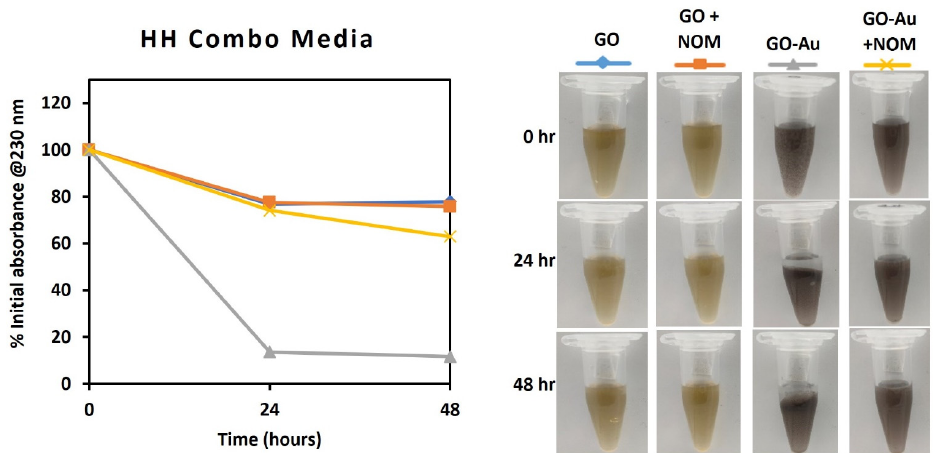
Figure 6. Monitoring of dispersion stability of GO and GO-Au in HH Combo media with and without NOM (20 mg/L). (left): Absorbance measured in UV ‐ vis; (right): Photographs for visual observa ‐ tion.